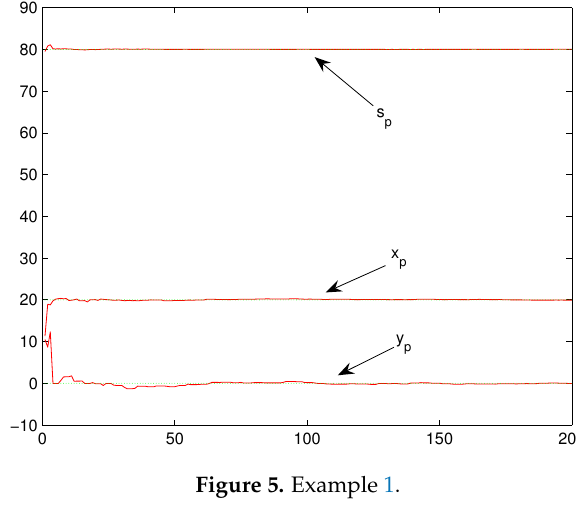
Figure 5. Example